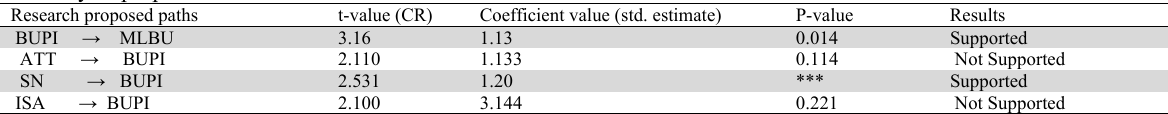
Summary of proposed results for the theoretical